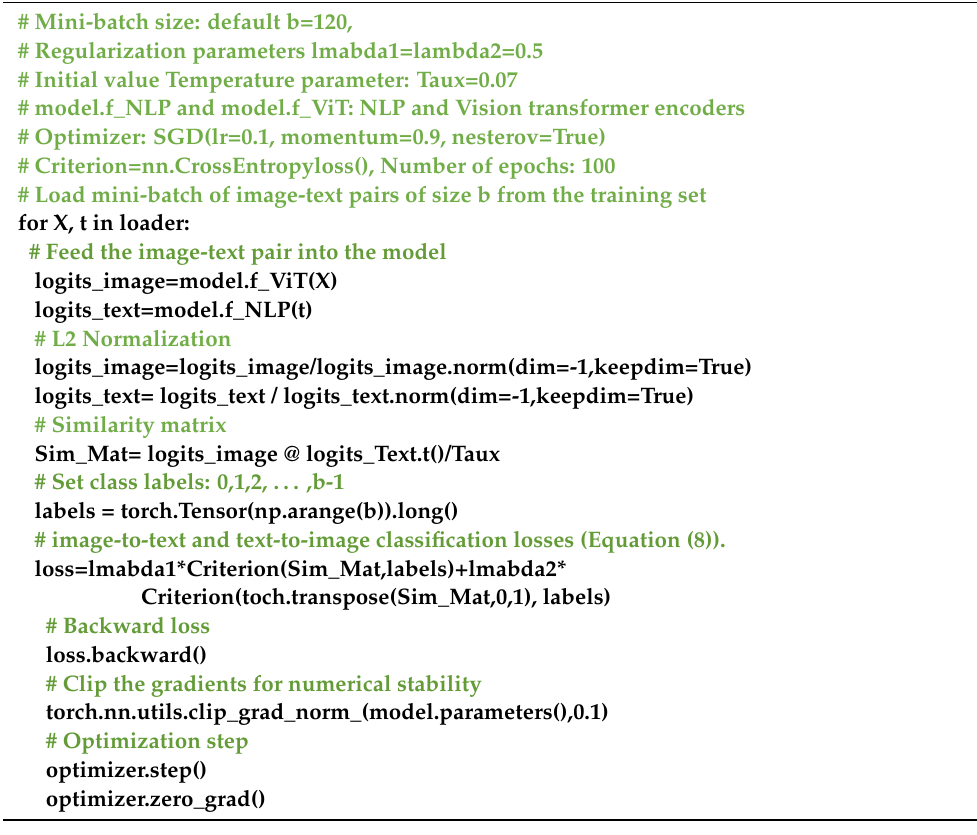
Algorithm 1: Cross-modal text–image matching PyTorch-style